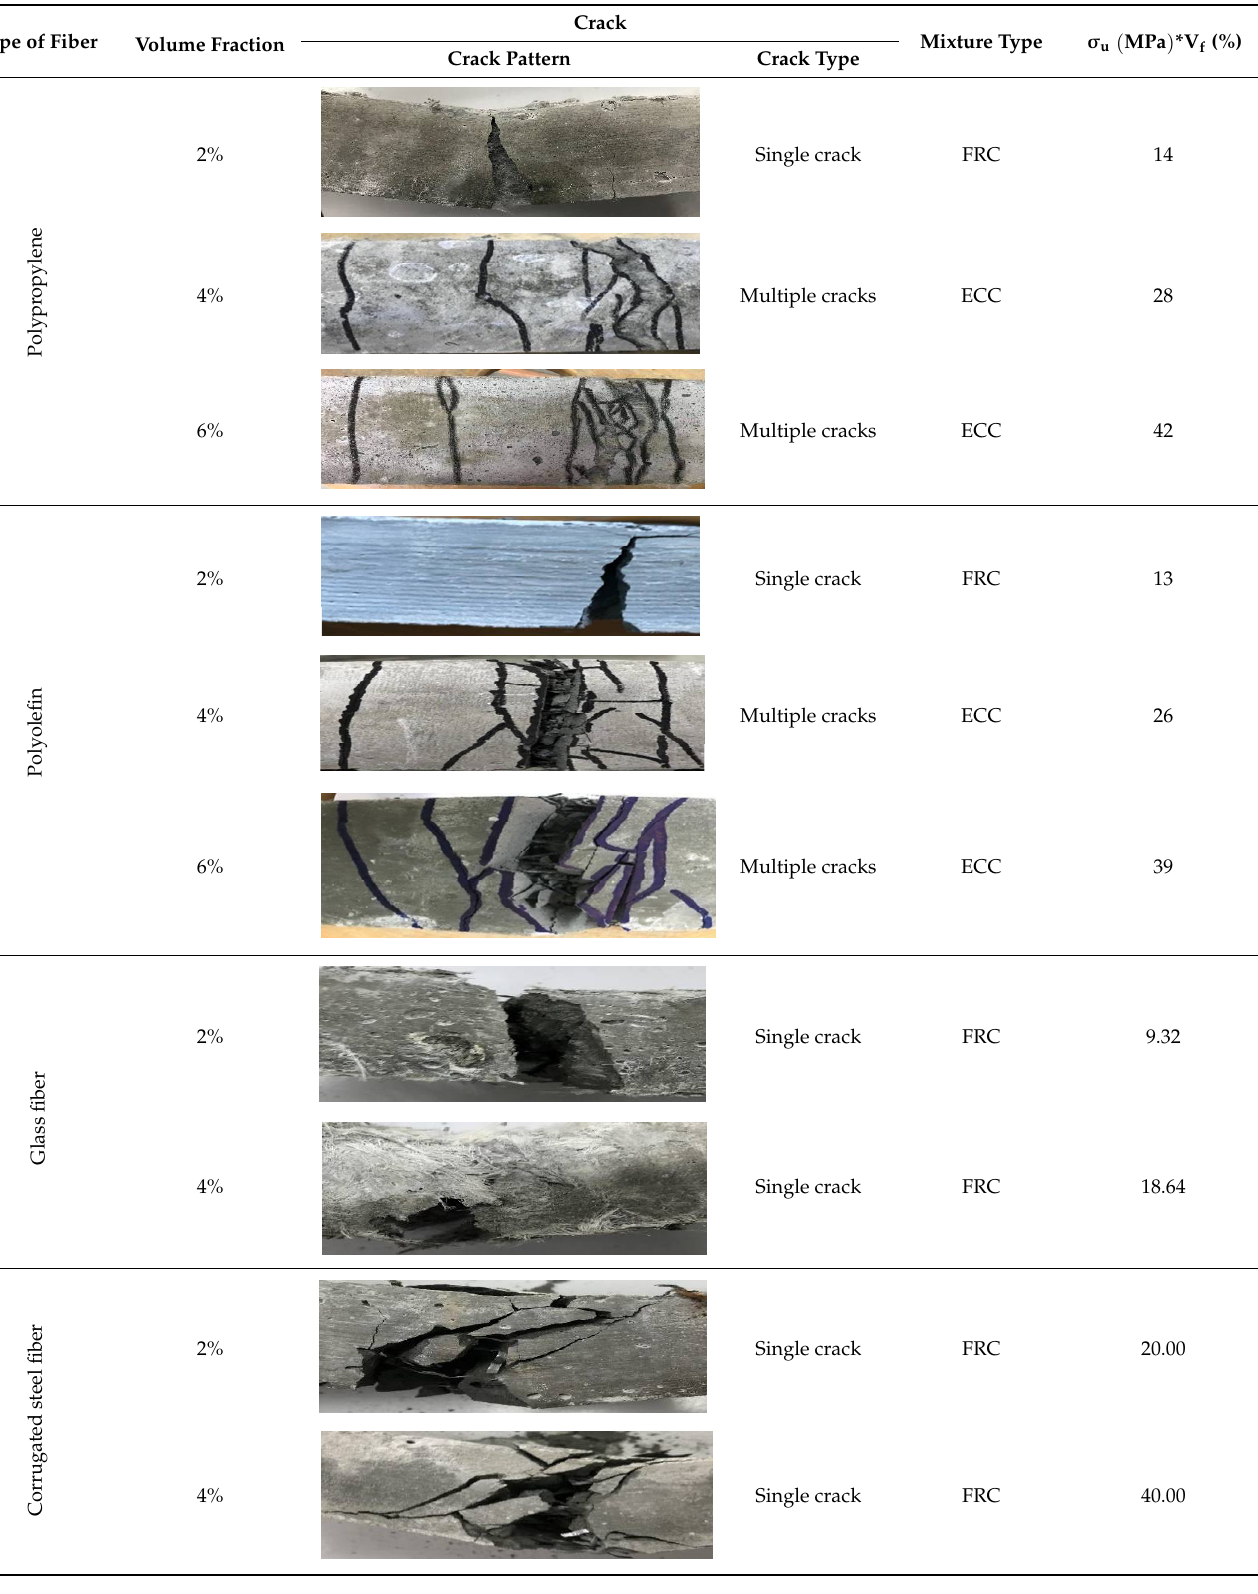
Table 4. ECC and FRC crack pattern of mixtures reinforced with a single fiber.